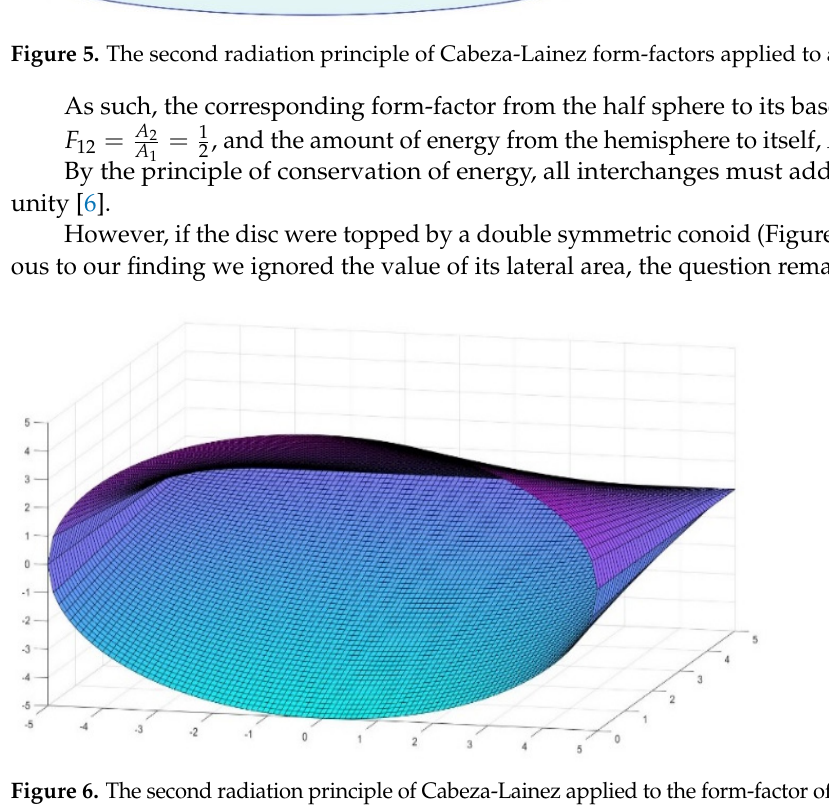
Figure 5. The second radiation principle of Cabeza ‐ Lainez form ‐ factors applied to a hemisphere.